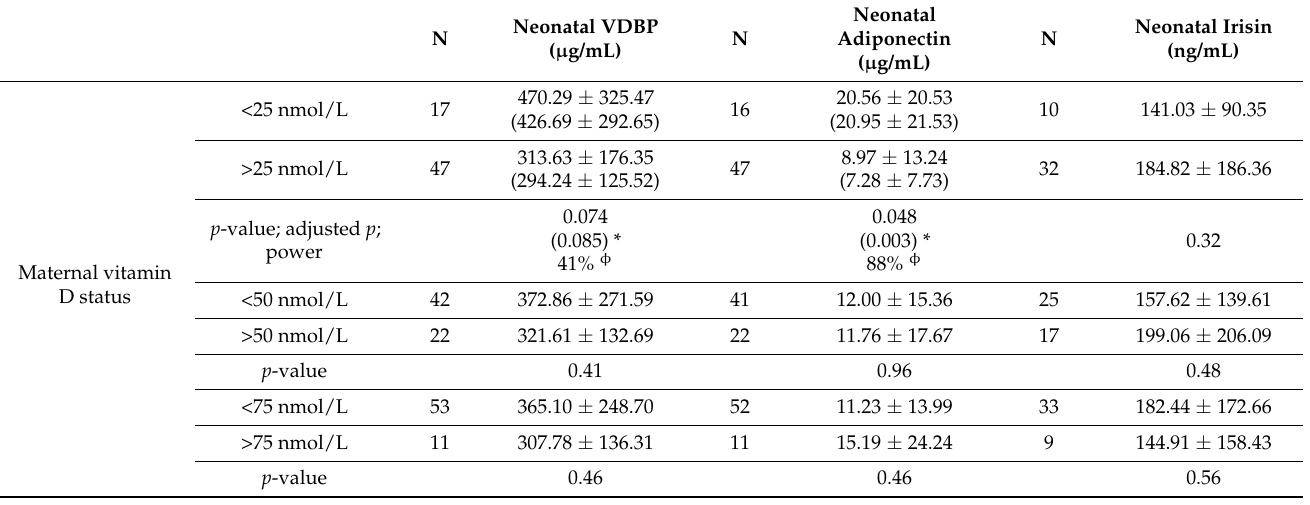
Table 2. Neonatal serum biomarkers according to maternal vitamin D